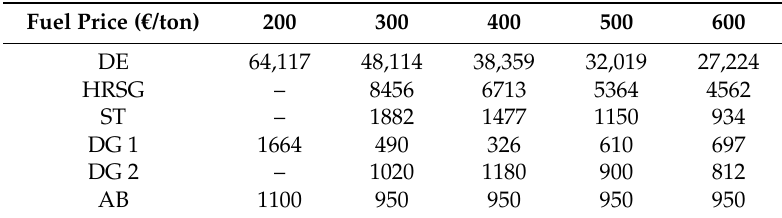
Table 37. Effect of fuel price on the optimal design specifications of the system for double freight rate (the numbers give the nominal power in kW).